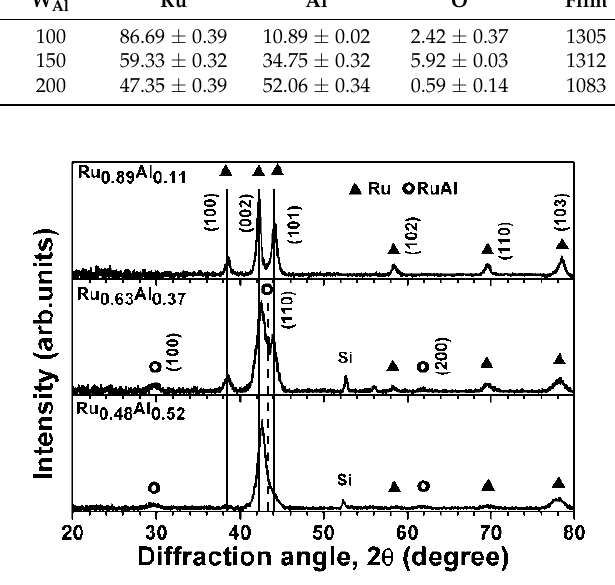
Figure 2. X-ray diffractometer (XRD) patterns of as-deposited Ru–Al thin films.